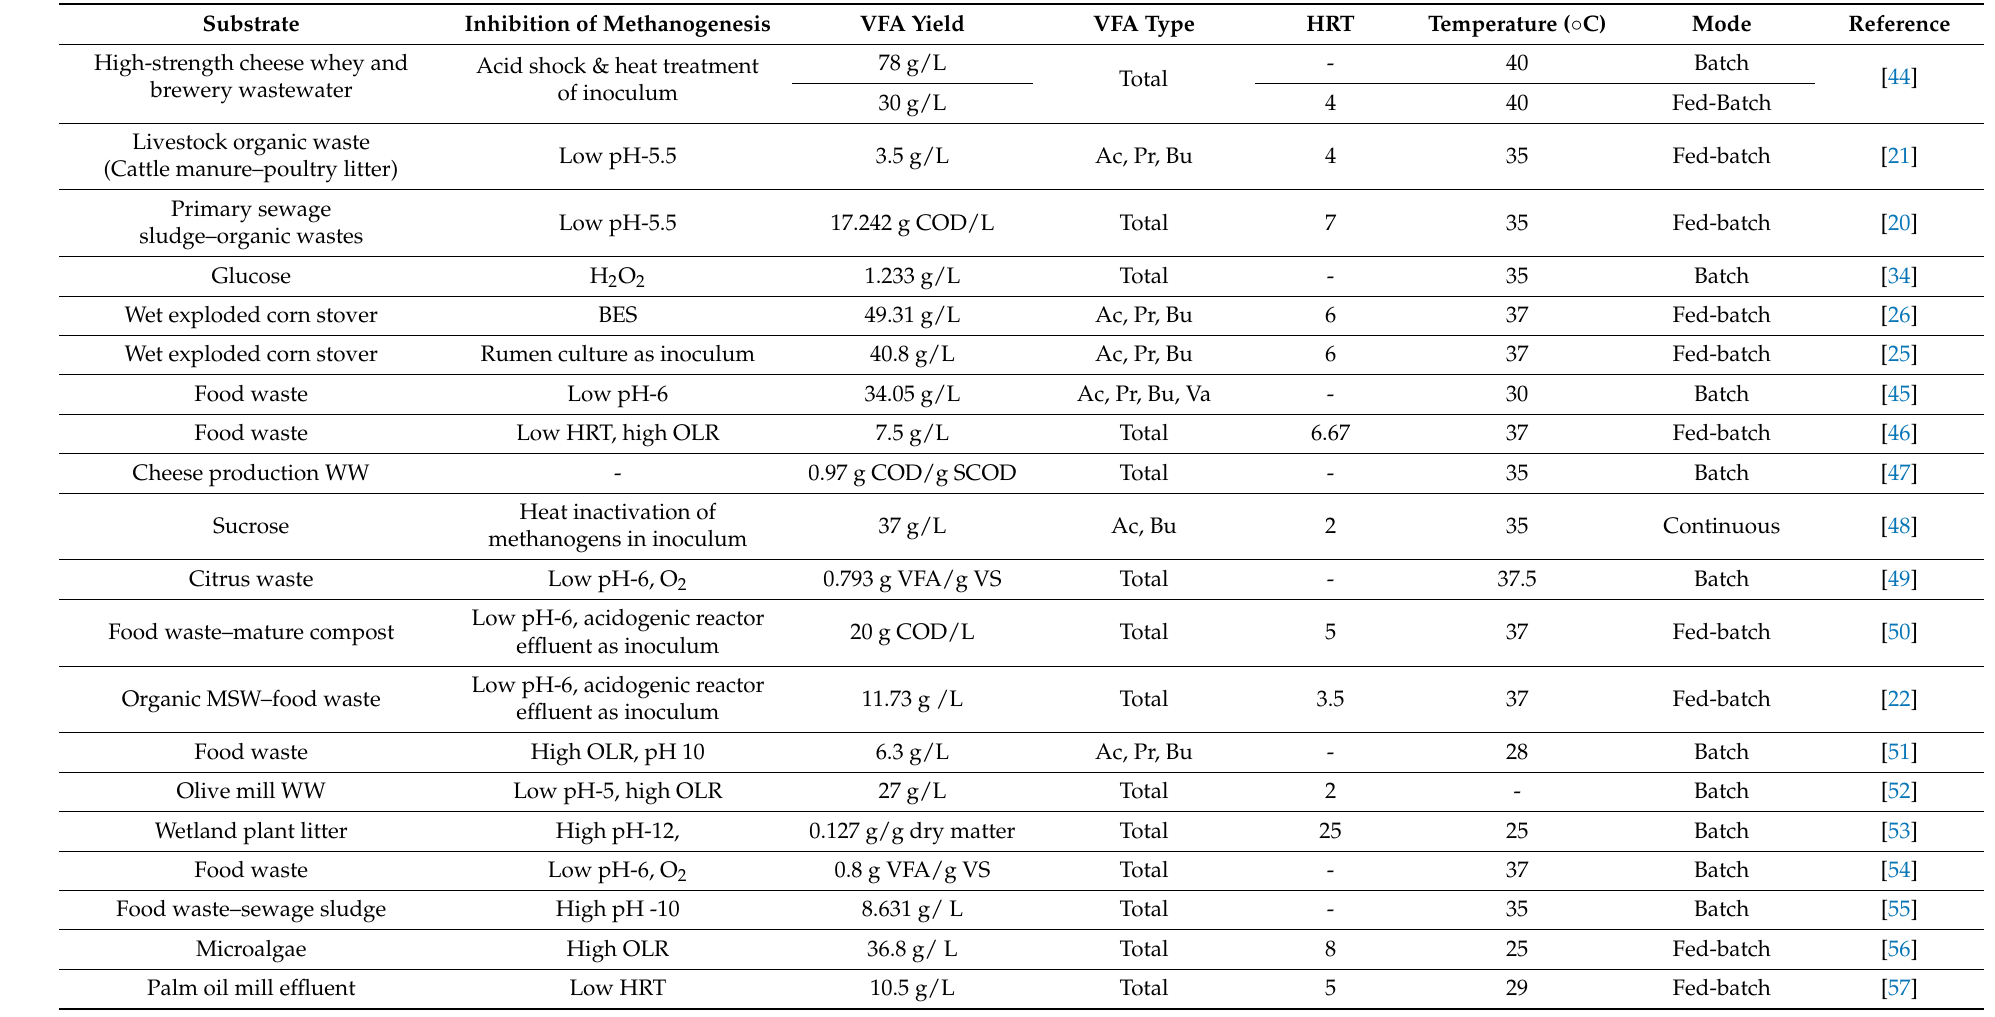
Table 1. Summary of studies of AAD using different substrates and operating